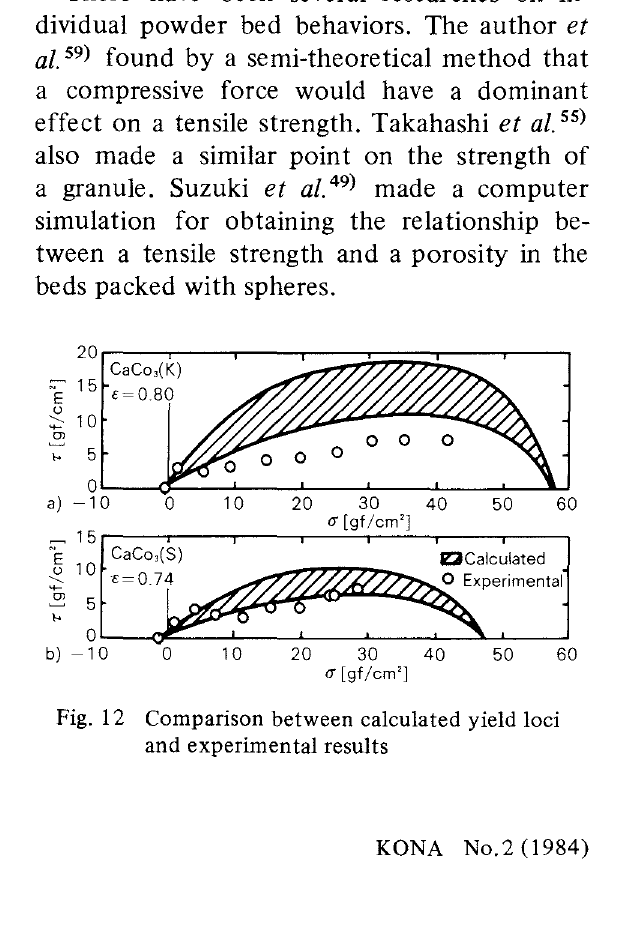
Fig. 12 Comparison between calculated yield loci and experimental